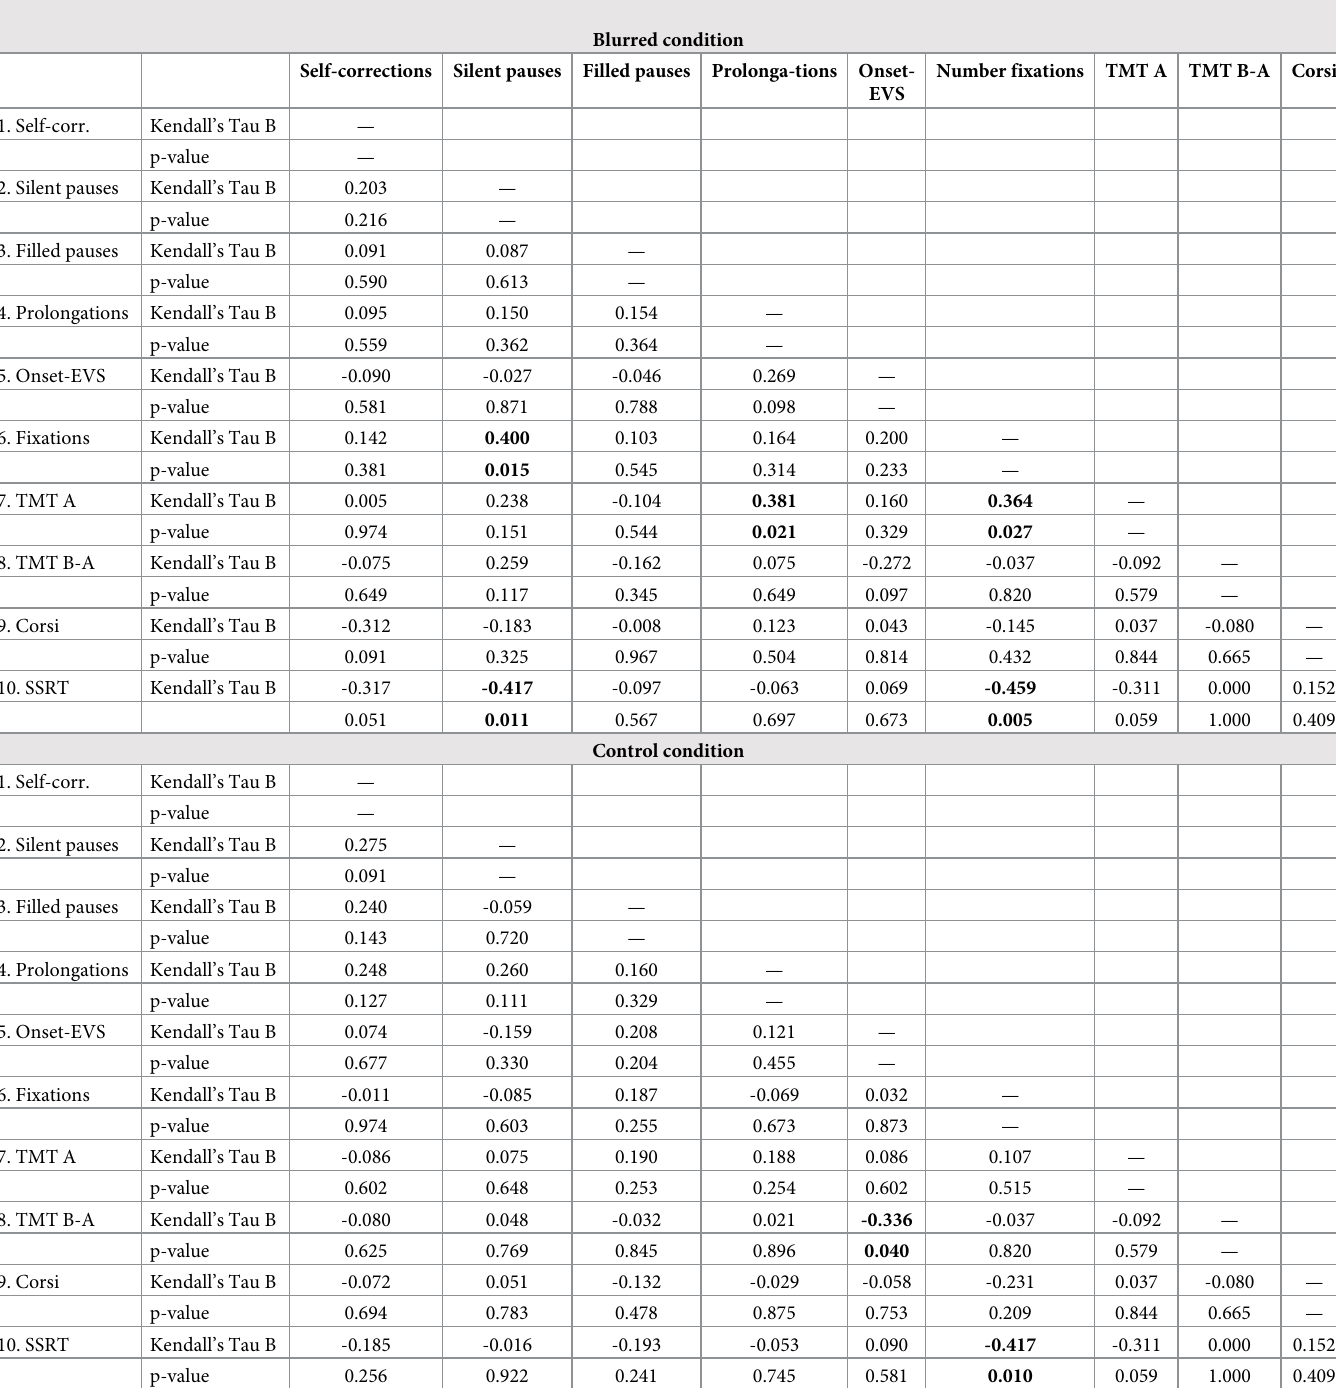
Table 4. Correlations between cognitive performance and disfluency and eye-movements in each